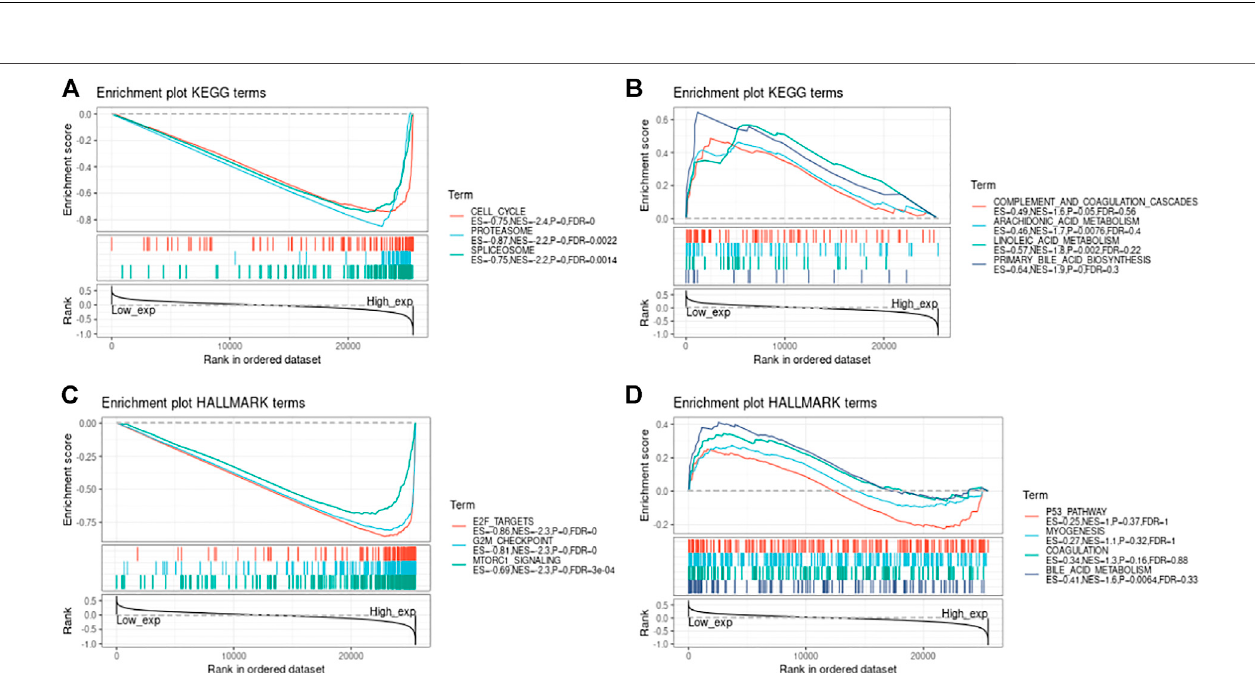
FIGURE 15 | Enrichment performance of genes in KEGG and HALLMARK pathways.